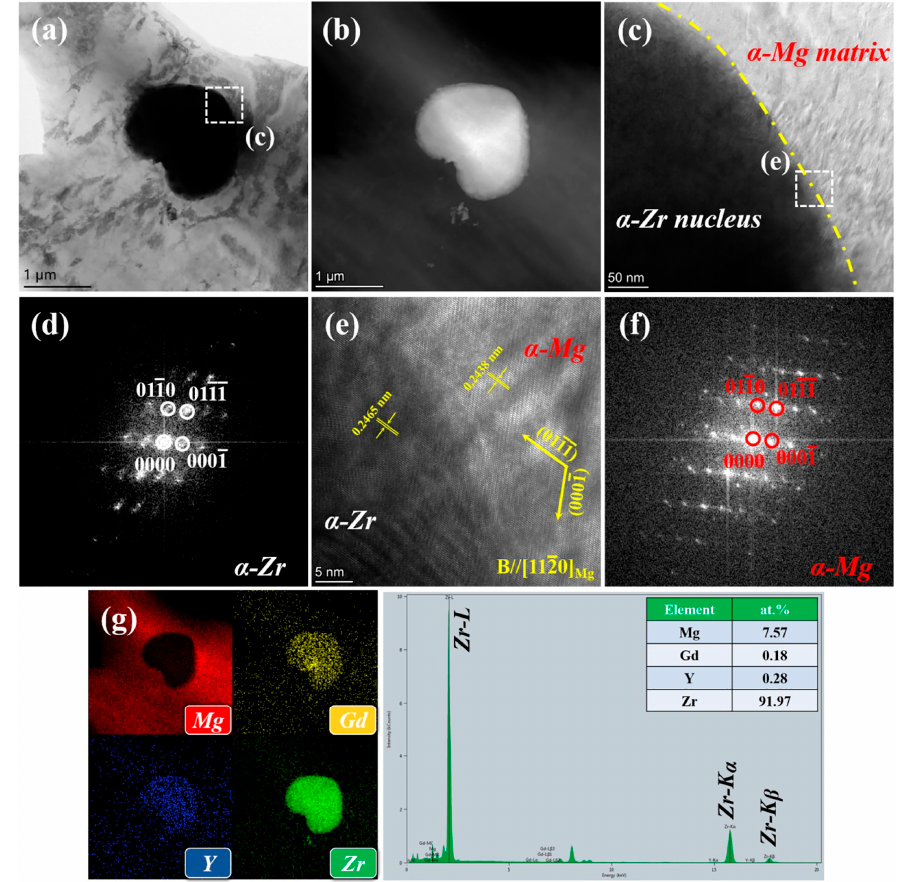
Figure 5. TEM showing OR between Mg matrix and Zr nucleus in Mg-8Gd-3Y-0.82Zr alloy: ( a ) bright-field image; ( b ) dark-field image; ( c ) enlarged view of the selected area in ( a ); ( e ) HRTEM image of the interface between Mg matrix and Zr nucleus ( beam ∥ [21(cid:3364)1(cid:3364)0] (cid:3027)(cid:3045) ); ( d , f ) fast Fourier transform (FFT) spectrum of α -Zr and α -Mg, respectively; ( g ) EDS analysis of Zr nucleus. Reprinted with permission from ref. [23]. Copyright 2021 Elsevier.